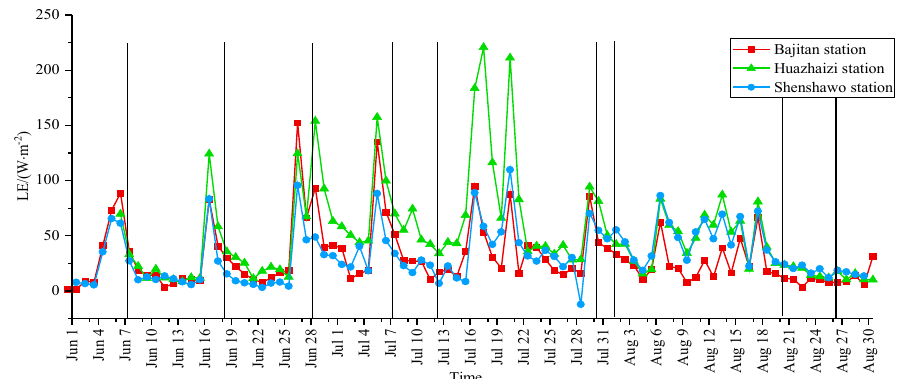
Figure 4. Frequency distribution within LE days under different underlying surface types. Table 2. LE statistical results of 9 days were synthesized under different types of underlying sur- faces.